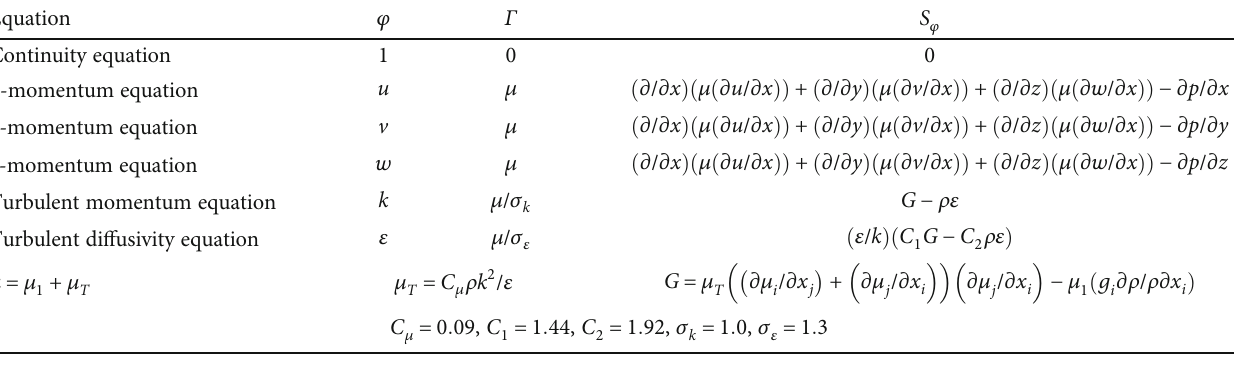
Table 1: Source term in control equation [13,